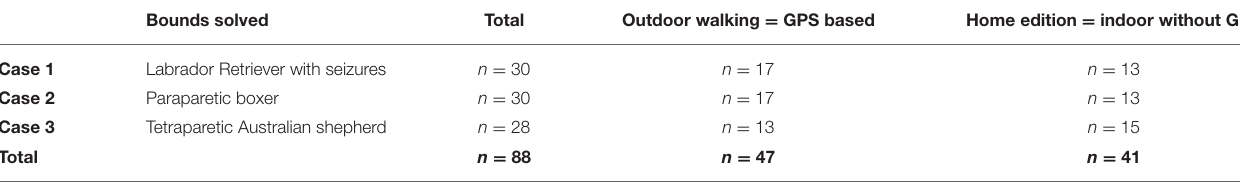
TABLE 3 | Amount of solved bounds. Bounds